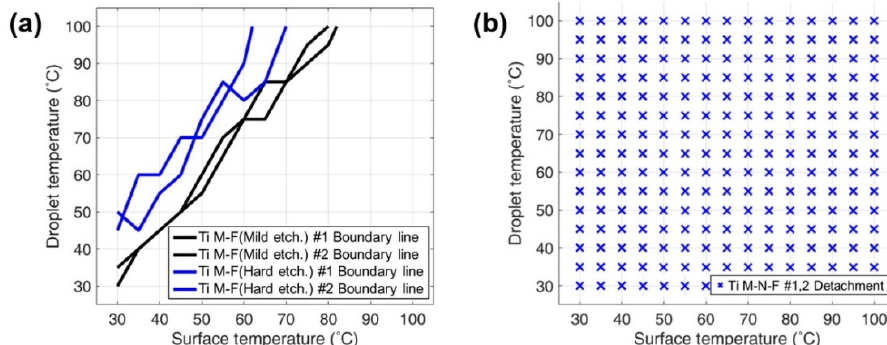
Figure 4. ( a ) Boundary lines of the DB maps of mild-etched Ti #1 and #2 (black lines) and hard etched Ti #1 and #2 (blue lines) surfaces. ( b ) DB map of Ti M-N-F #1, #2 surfaces.